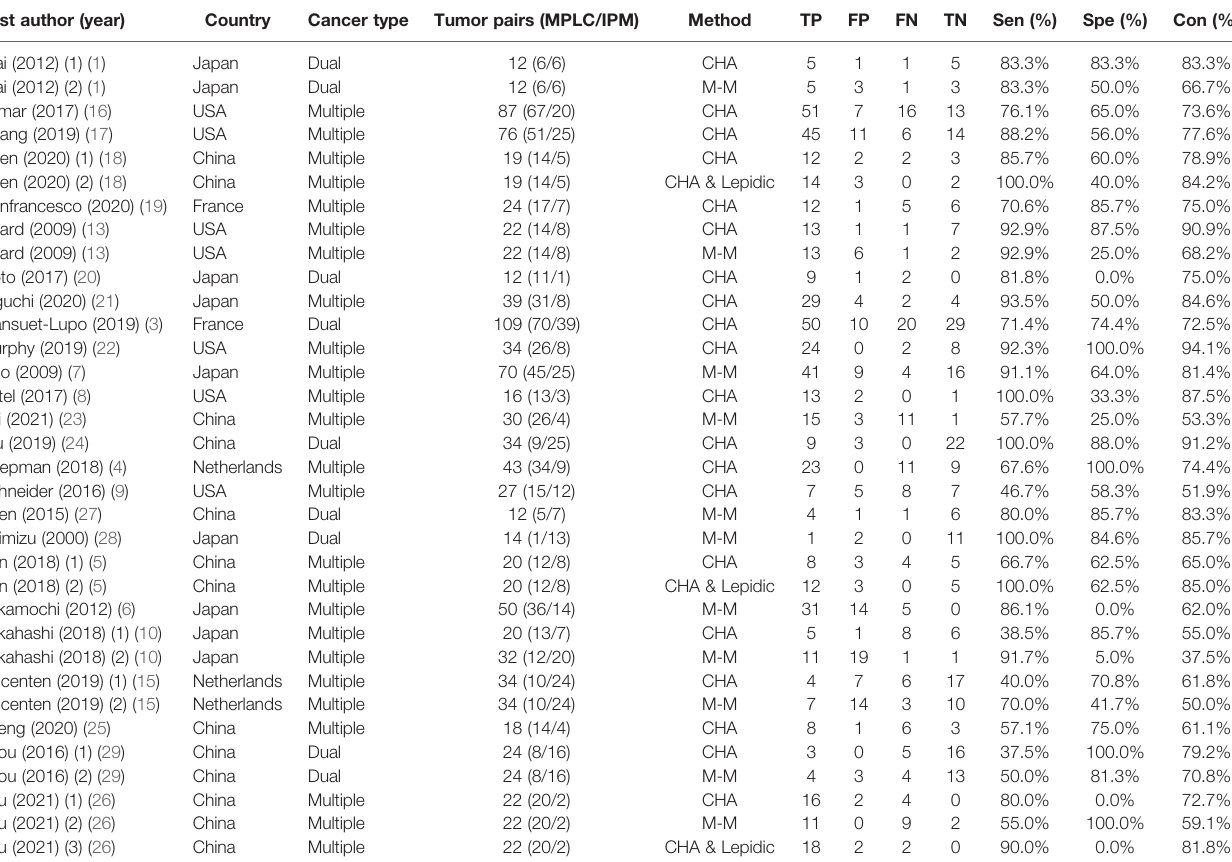
TABLE 1 | Summary of the 34 studies included in the